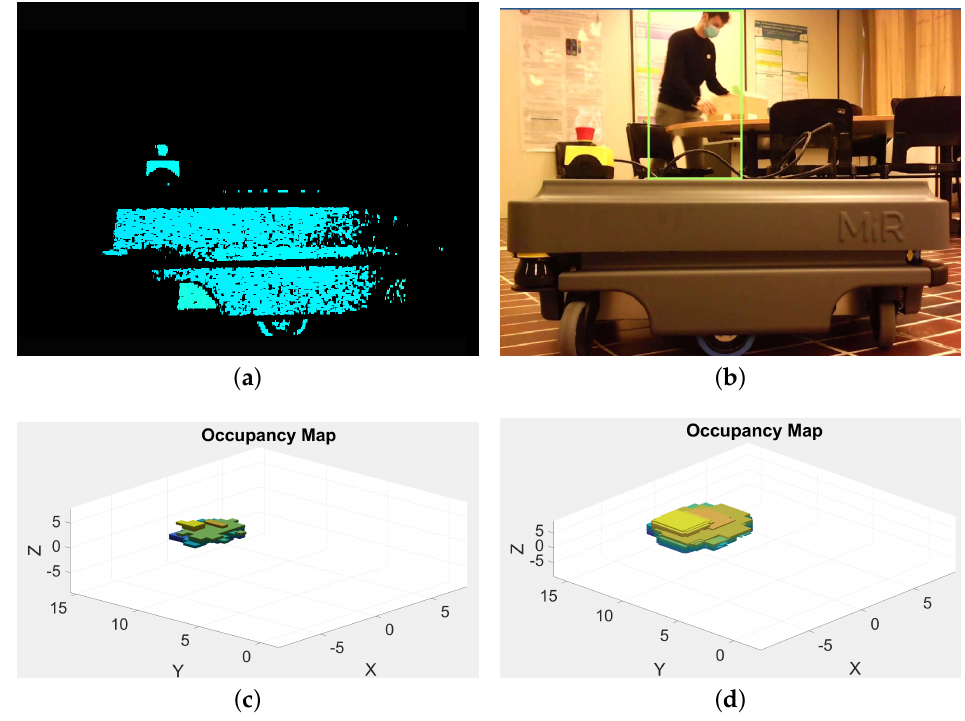
Figure 10. RGB-D data processing and occupancy map reconstruction. ( a ) Depth space image acquisition of Mir200 AGV. ( b ) Human detection in long-range with YOLO CNN based on RGB image. ( c ) Occupancy map created with Octotree structure, the axes measurement units are assumed as 1 unit = 10 − 1 m. ( d ) Occupancy map with inflation radius of 0.2 m, the axes measurement units are assumed as 1 unit = 10 − 1